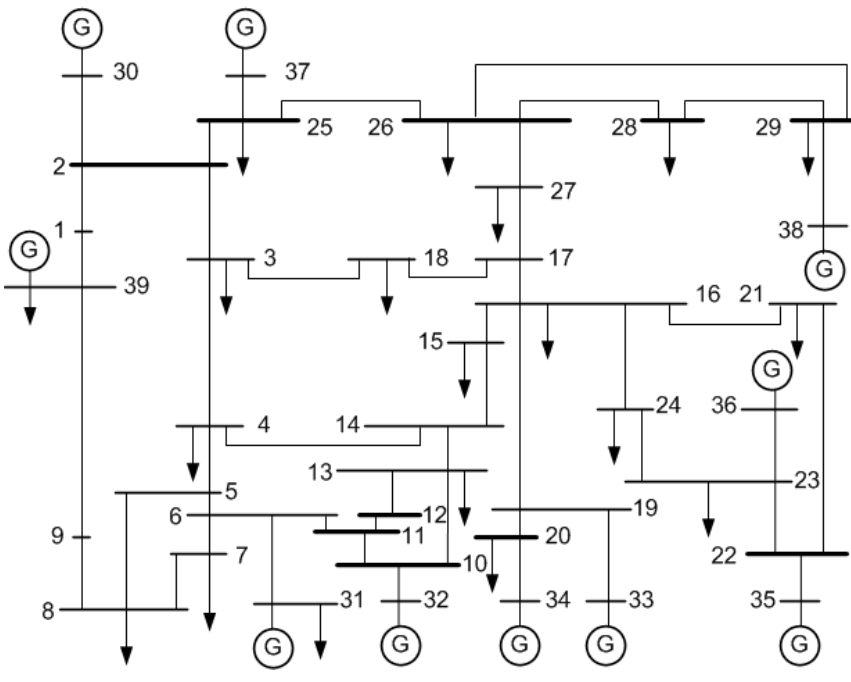
Figure 3. One line diagram of the IEEE 39-bus test system.